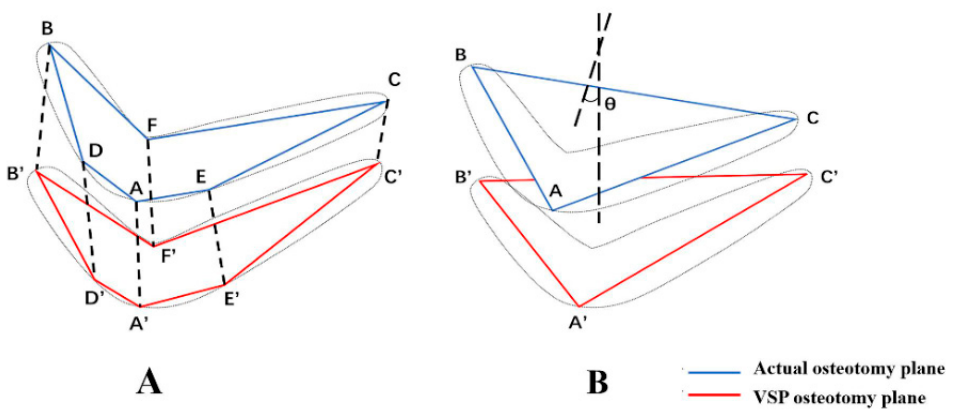
Figure 5. Diagram illustrating the measurement of distance error and the direction error of the osteotomy plane. ( A ) Distance error. ( B ) Direction error.